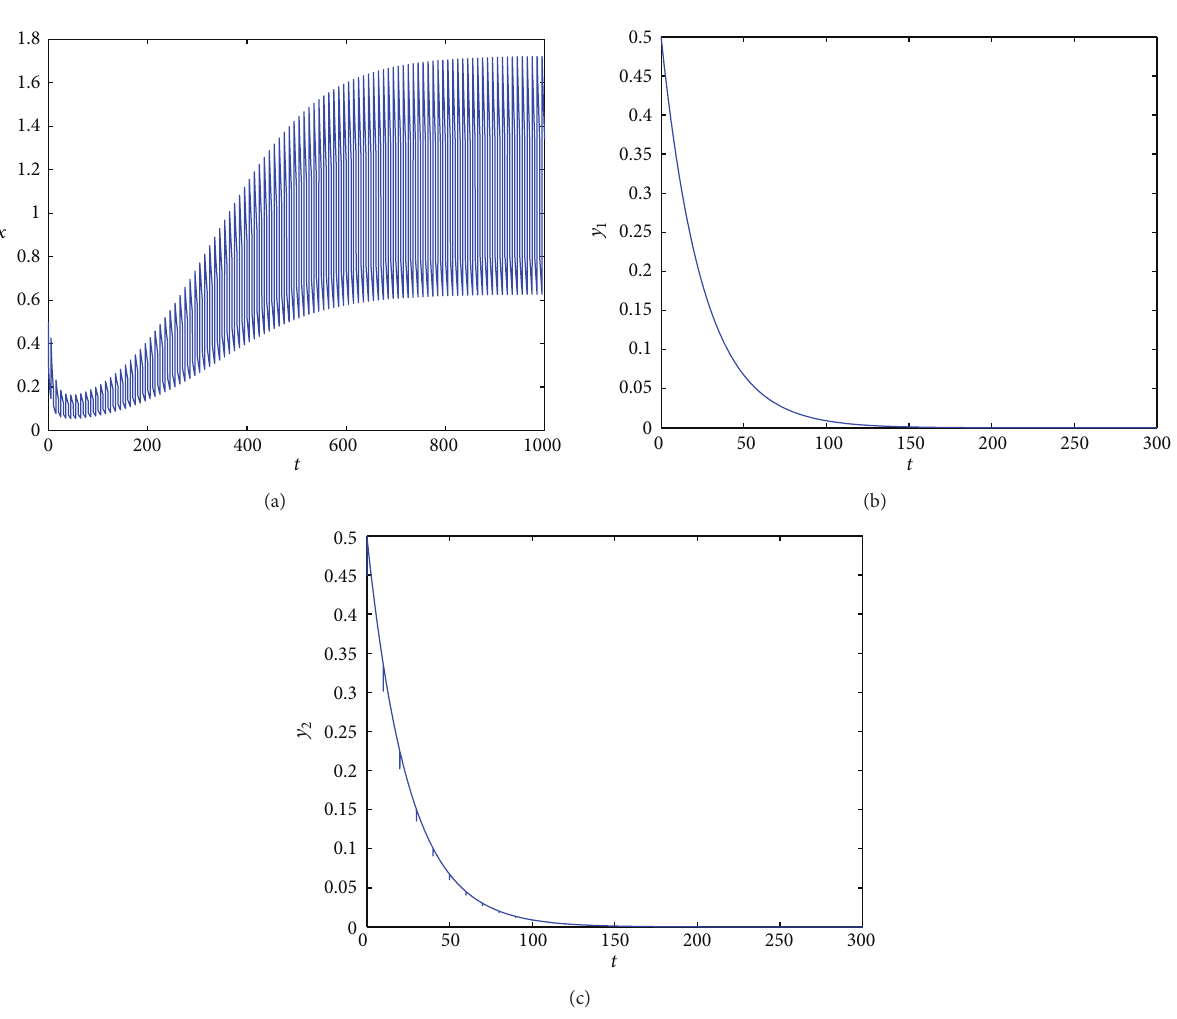
Figure 1: Dynamical behavior of system (4) with 𝑟 = 2 , 𝐾 = 5 , 𝛽 = 1 , 𝑐 = 10 , 𝑑 1 = 0.5 , 𝜆 = 1 , 𝑑 2 = 0.4 , 𝑑 3 = 0.3 , 𝑑 4 = 0.1 , 𝑝 1 = 0.4 , = 0.1 , 𝜏 = 0 , 𝑇 = 1 . (a) Time series of the prey population; (b) time series of the immature predator population; (c) time series of the 𝑝 2 mature predator